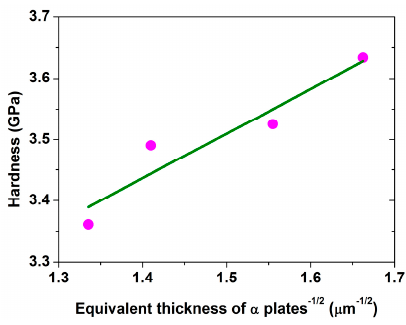
p , ( b ) α plates region.